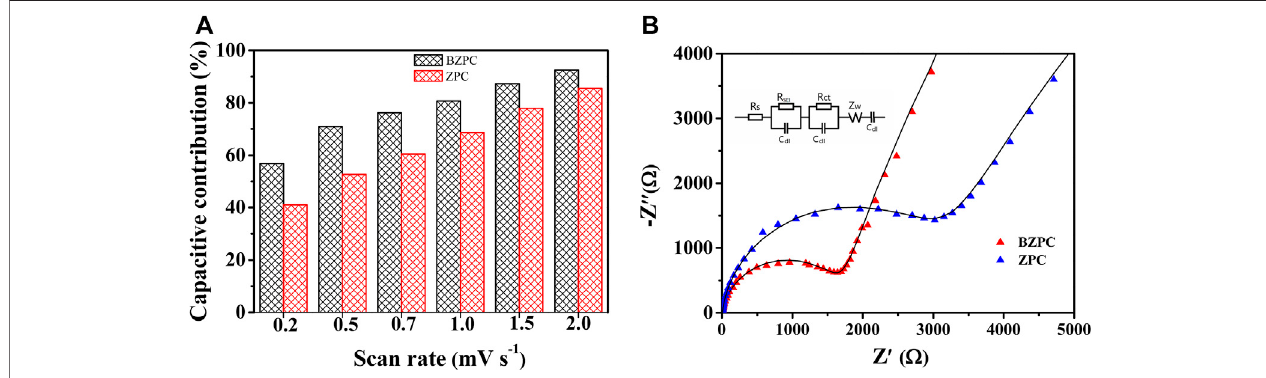
FIGURE 6 | (A) Capacitive contributions at various scan rates from 0.2 to 2 mV s − 1 , and (B) Nyquist plots of ZPC and BZPC (Inset: equivalent circuit diagram).